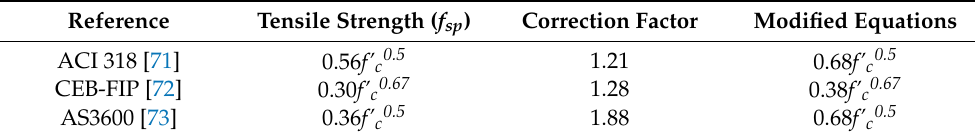
Figure 12. ( a ) Correlation between splitting tensile strengths, f sp , and compressive strength, f’ c . ( b ) Experimental versus predicted splitting tensile strengths, f sp . Table 9. Equations relating splitting tensile strength and compressive